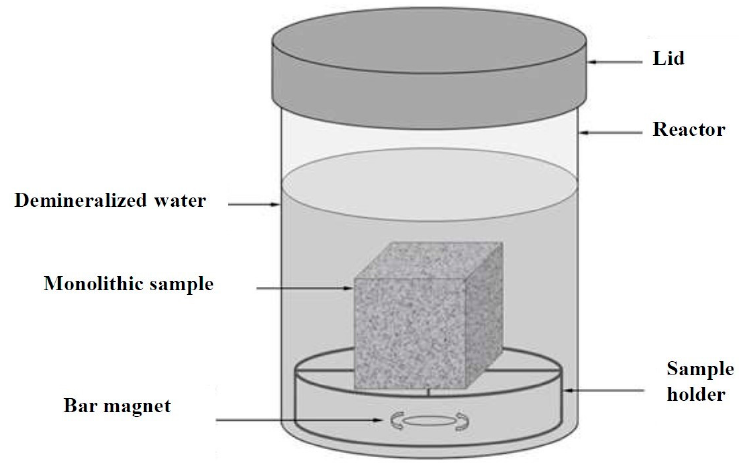
Figure 2. Experimental design for dynamic monolith leaching test applied on polymer mortar samples.